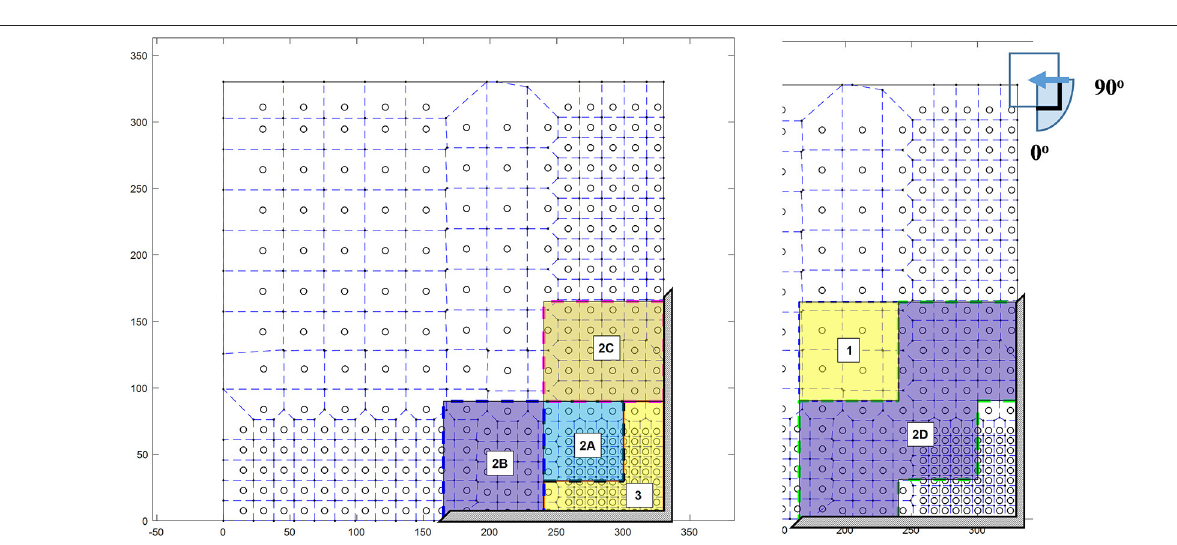
The area averaged results for the worst case scenario of each zone (minimum of all directions) are shown in Table 3 . For the zone 3 which is the most critical zone with a C p min,3s of